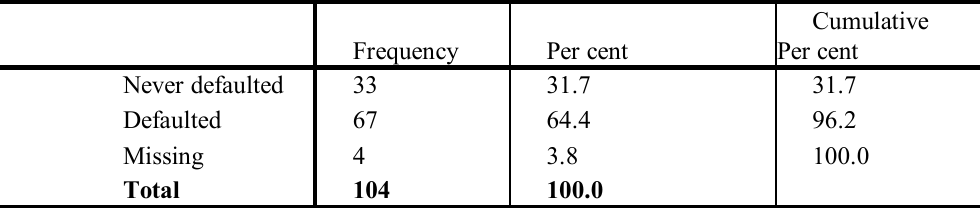
Table 5: Defaulted and non-defaulted households on mortgages